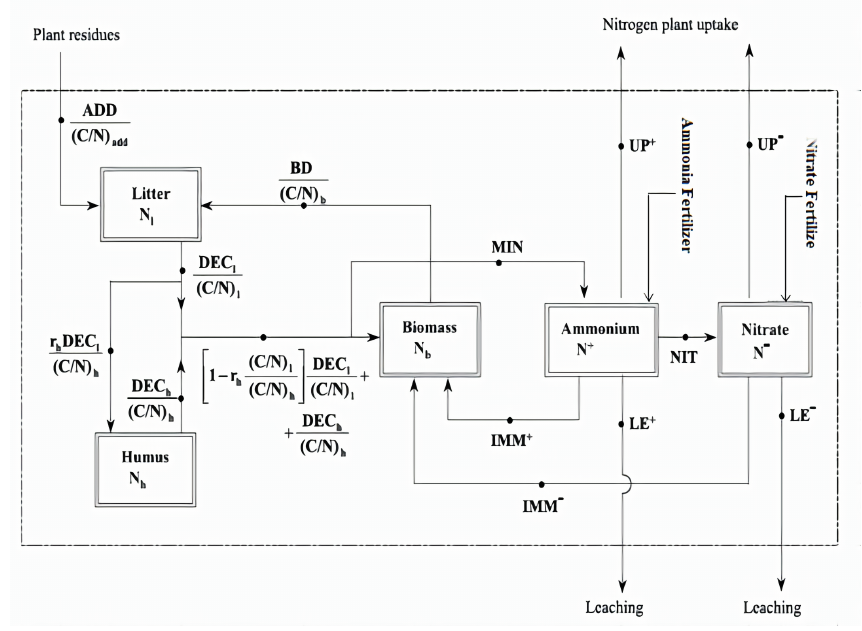
Figure 3. Various Nitrogen pools of the lean soil nutrient dynamics model